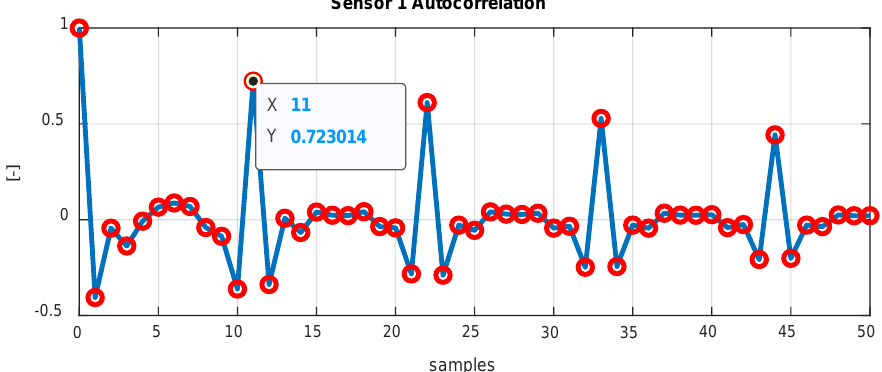
Figure 3. Average of short-time autocorrelations on difference signal–window: 100 samples, overlap: 0 samples. N.B., just the first 50 positive shifts are shown.